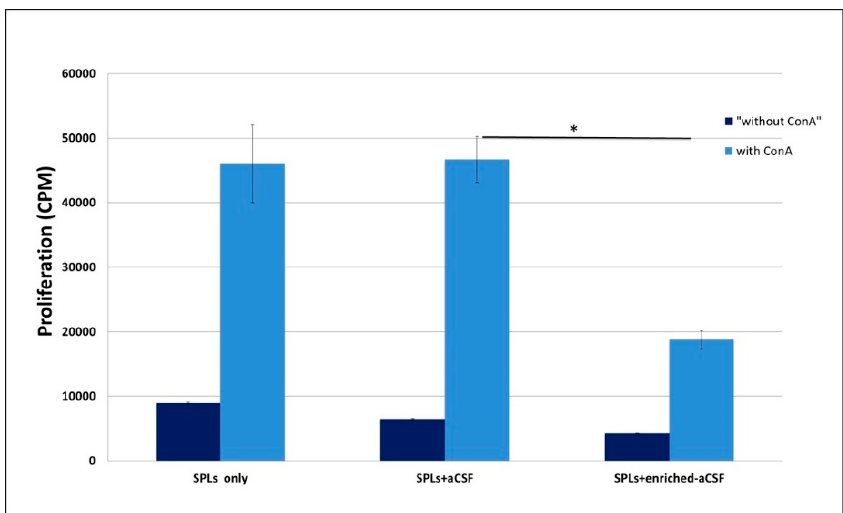
Figure 3. Suppression of splenocyte proliferation by the enriched-aCSF. Mouse splenocytes were grown with aCSF enriched with the MSC secretions or with unenriched-aCSF (or splenocytes only) and assayed for proliferation in response to ConA. The enriched-aCSF treated splenocytes showed significantly lower proliferation than the unenriched-aCSF treated mice ( t -test, p < 0.0007). Unenriched-aCSF treated mice showed similar proliferation to splenocytes only (untreated). CPM = counts per minute. SPL = splenocytes.